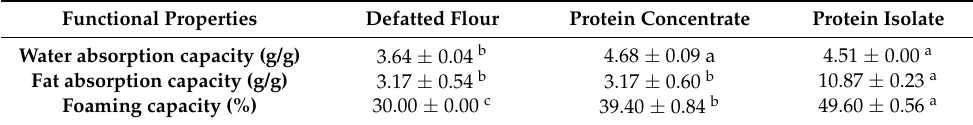
Table 8. Functional properties of defatted flour, protein concentrate, and protein isolate of Brachytrupes membranaceus